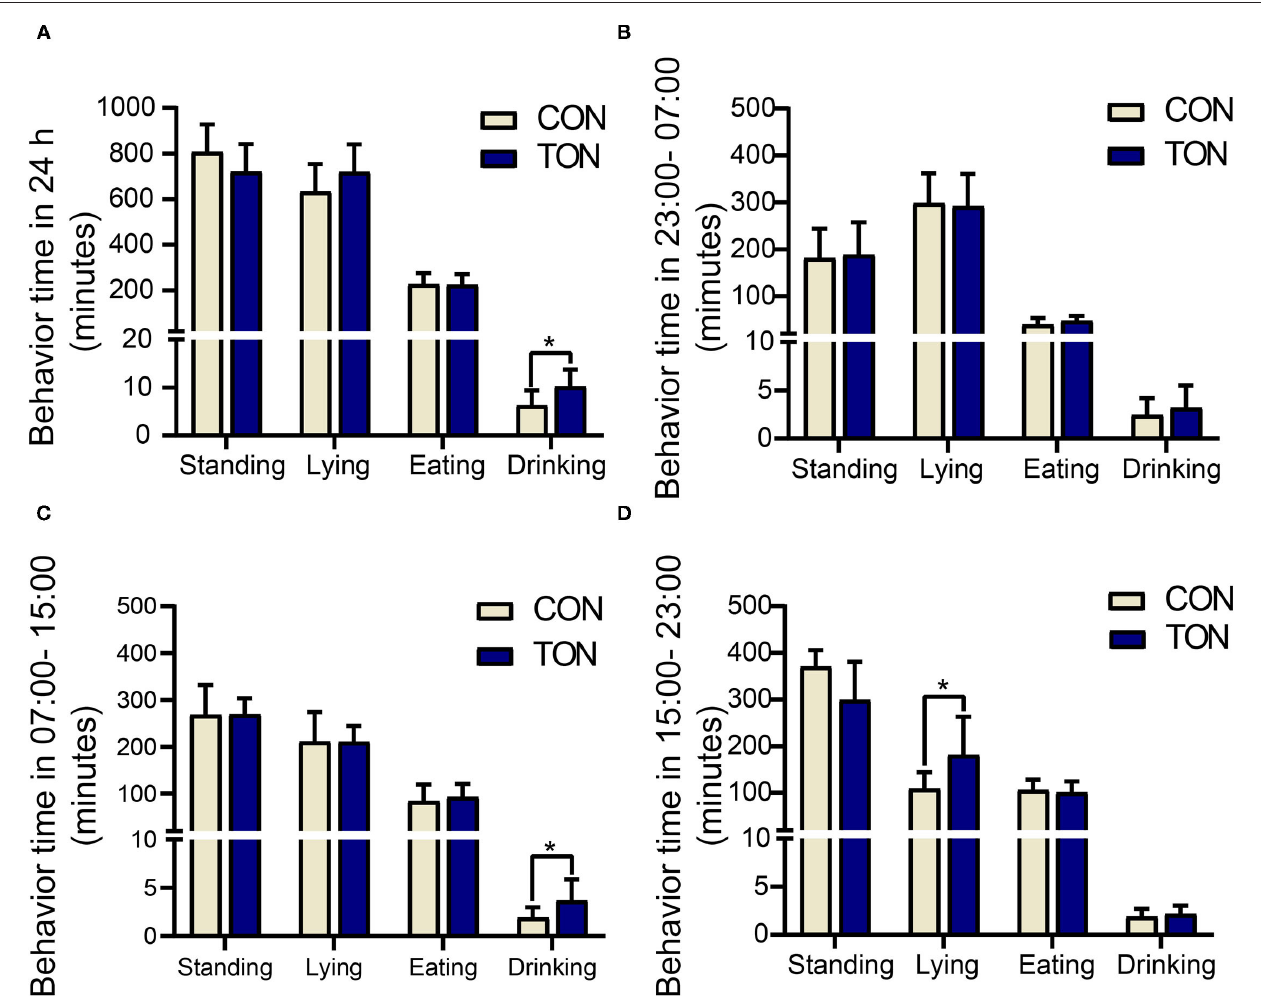
FIGURE 1 | Minutes of activities in TON and CON. (A) Behavioral duration of TON and CON cows during 24h. (B) Behavioral duration of TON and CON cows in 23:00-07:00. (C) Behavioral duration of TON and CON cows in 07:00-15:00. (D) Behavioral duration of TON and CON cows in 15:00-23:00. TON, cows with tongue rolling behavior; CON, cows without abnormal behavior. * P <